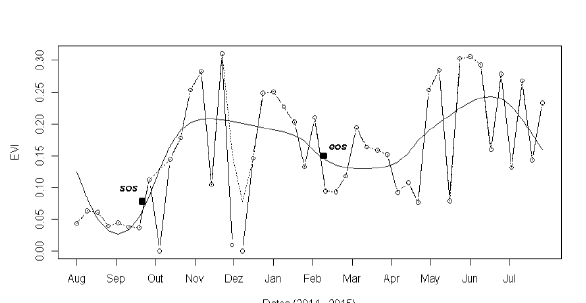
Figure 3. Time series EVI spectral profile for an annual crop sample located into a triple cropping system of potato, bean and corn. Dotted line represents the time series outliers and null values removed and the thick line represents the double logistic filtered time series.